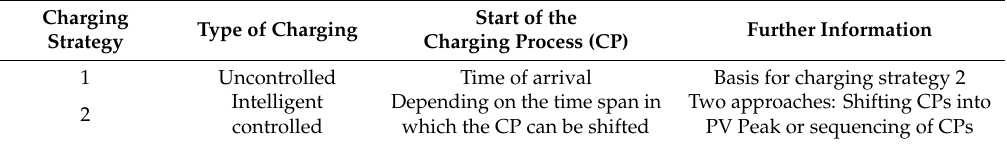
Table 1. Comparison of charging strategy 1 and charging strategy 2.